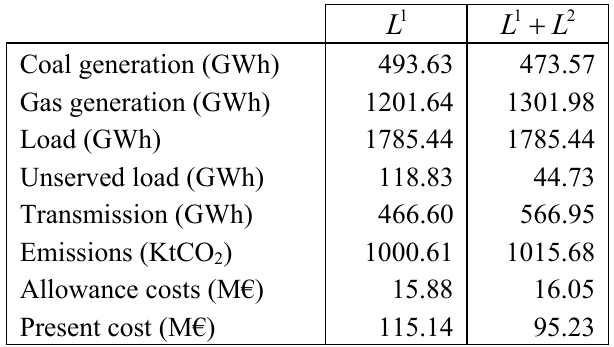
Table 8. No uncertainty in load